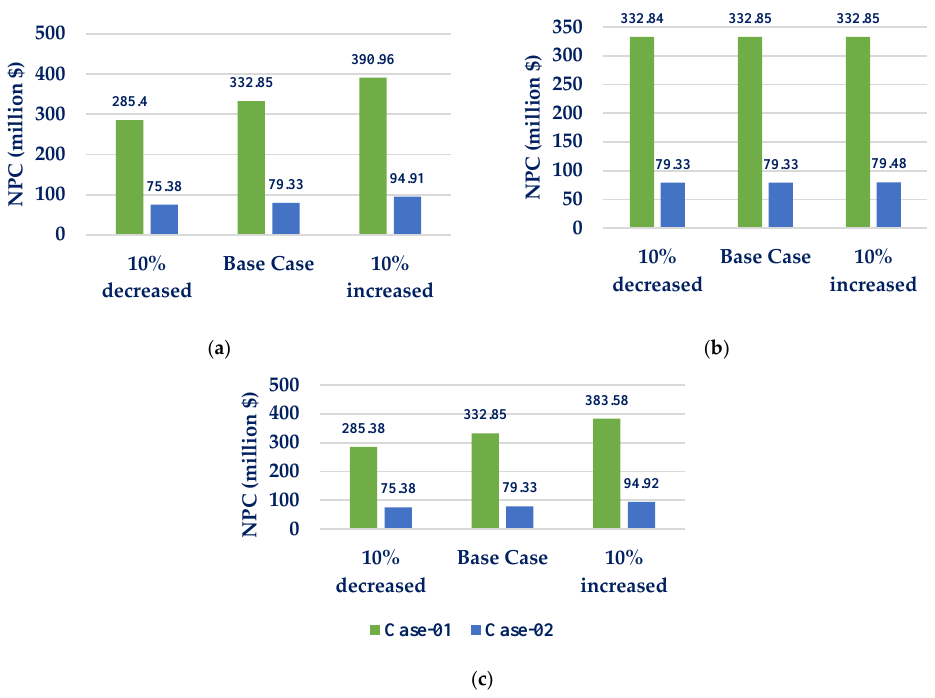
Figure 20. Impact on NPC due to variation in average ( a ) electric demand; ( b ) thermal demand; ( c ) both.